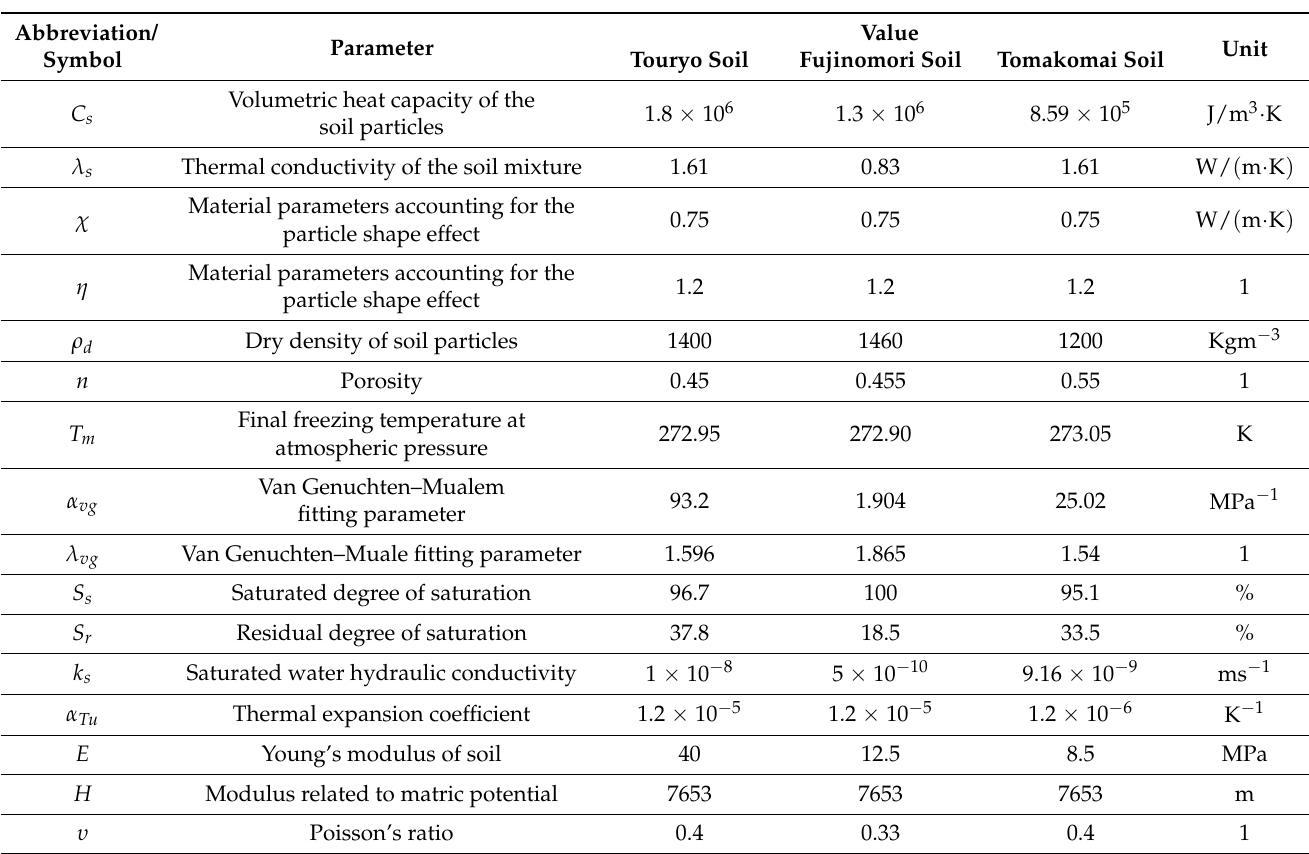
Table 3. List of soil